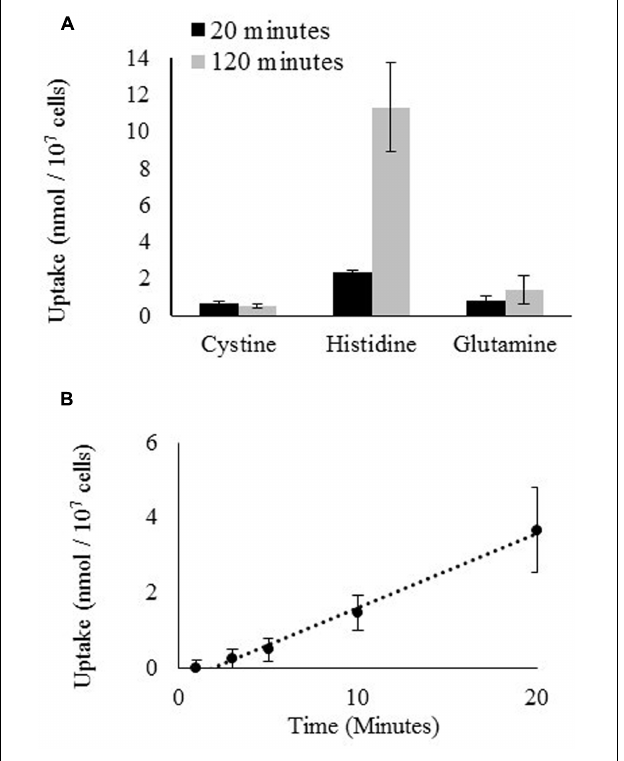
FIGURE 5 | Uptake of radiolabeled amino acids by D. viridis. (A) Accumulation of L-cystine [3,3 (cid:48) - 14 C], L-histidine [2,5- 3 H], and L-glutamine [3,4- 3 H(N)] in cells of D. viridis after 20 and 120 min when supplied with 1 mM amino acids. (B) Time course kinetics of L-histidine [2,5- 3 H] uptake at 1 mM in mBA -N. Means ± Standard error of three biological replicates are shown.